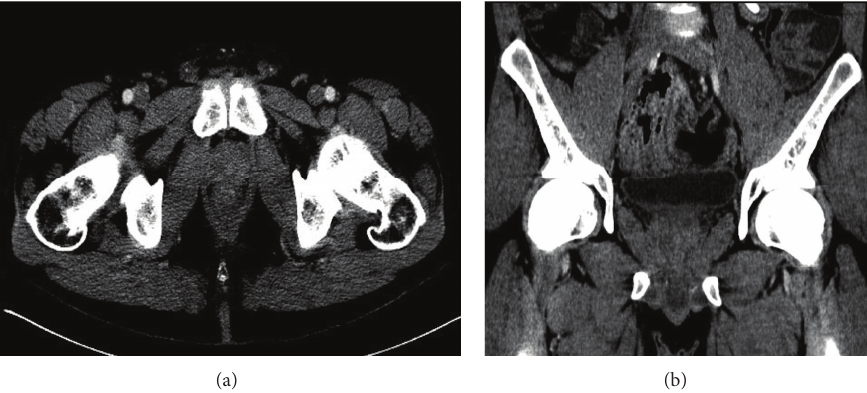
Figure 2: Axial (a) and coronal (b) views of CT abdomen and pelvis with contrast after completion of 6 weeks of intravenous antibiotic therapy showing resolution of prostatic